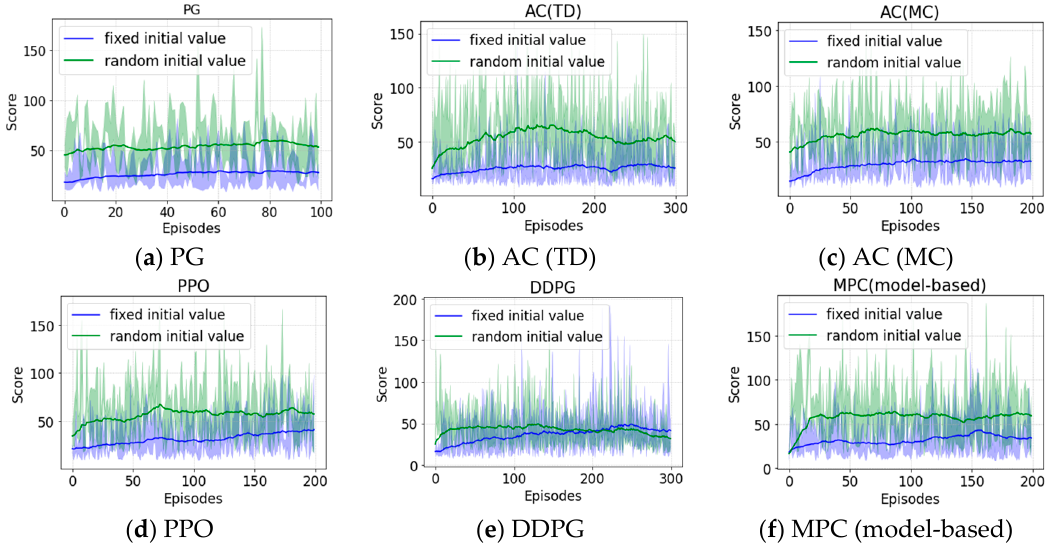
Figure 9. Curves of the six reinforcement learning algorithms for two tasks.